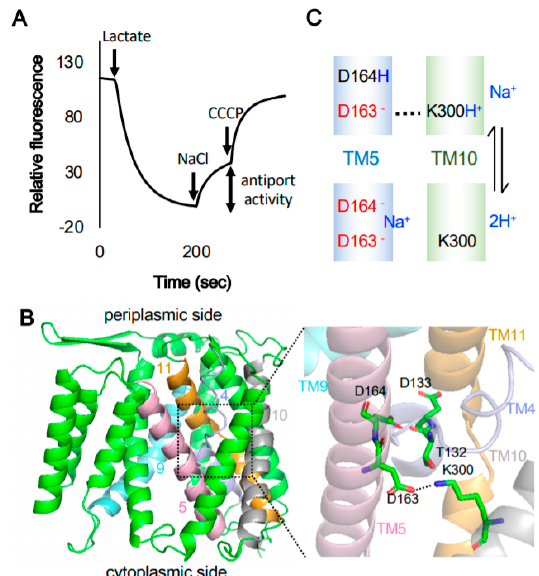
Figure 1. Structure and molecular function of NhaA. ( A ) Typical profile of the proton movement across an inverted membrane vesicle. Na + /H + antiporter activity is monitored by dequenching of a pH sensitive fluorescent probe like acridine orange. ( B ) Three-dimensional structure model of NhaA, the Na + /H + antiporter of E. coli (PDB 4AU5 [26]), was made by using PyMOL, version 2.3.5, Schrodinger LLC. Overview (left) and ion biding sites (right). The numbers in the left figure correspond to the numbers of the transmembrane domains. ( C ) Proposed mechanism of Na + and H + translocation by NhaA [26], D163 and K300 form a salt bridge (dotted line). When Na + binds to D163 and D164, the salt bridges are disrupted, and two protons are released from D163 and K300.